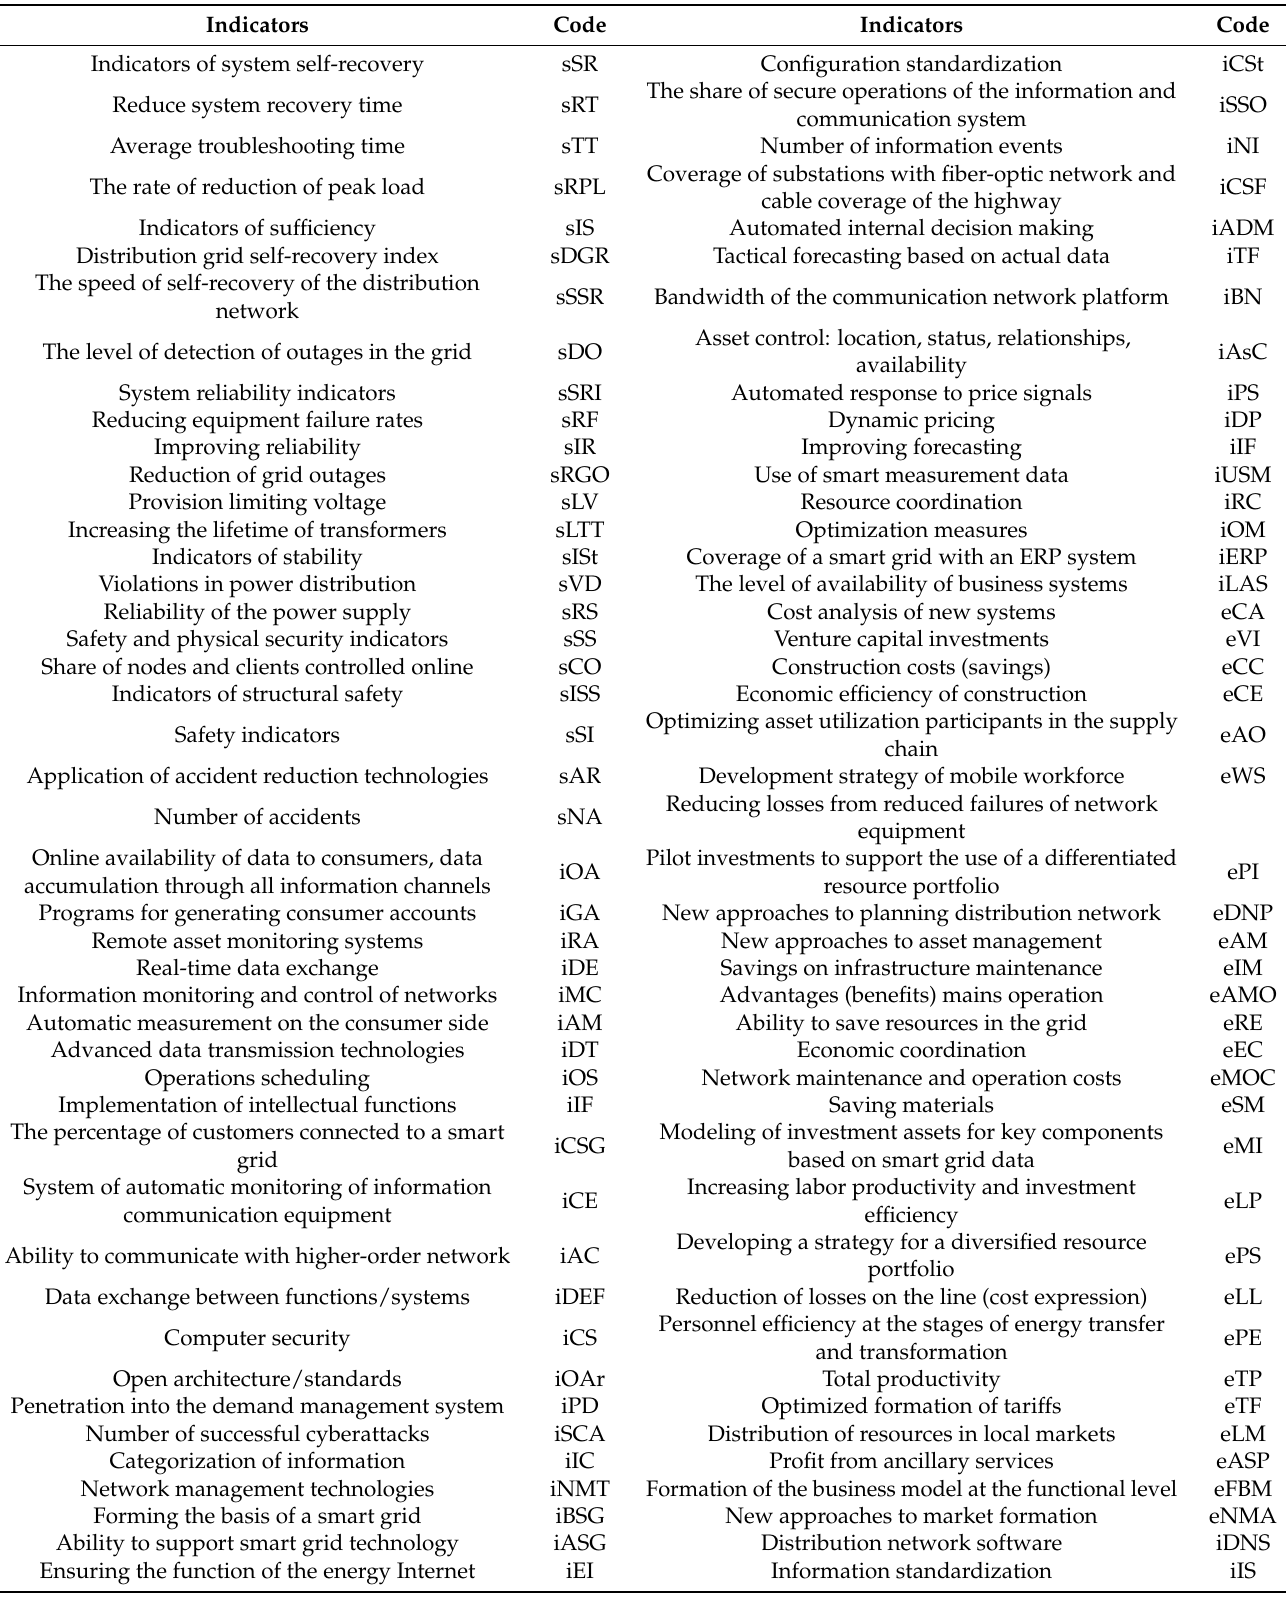
Table A1. Indicators by groups: the stability of the grid, information efficiency, and economic